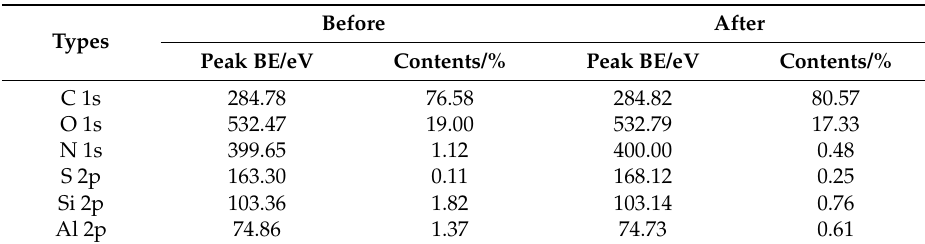
Table 2. Contents of C 1s, O 1s, N 1s, S 2p, Si 2p, and Al 2p on the coal surface before and after adsorption of NPEO 10.